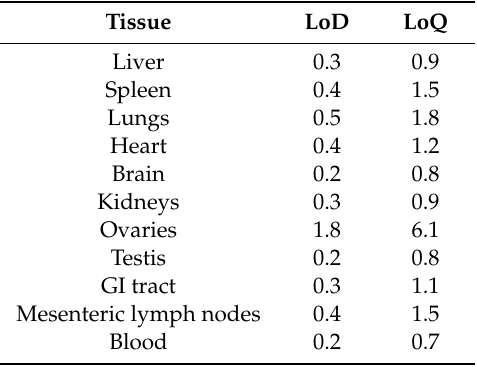
Table 2. Si determination by ICP-DRC-MS: limits of detection (LoDs) and limits of quantification (LoQs) for the di ff erent organs and blood ( µ g Si g − 1 fresh